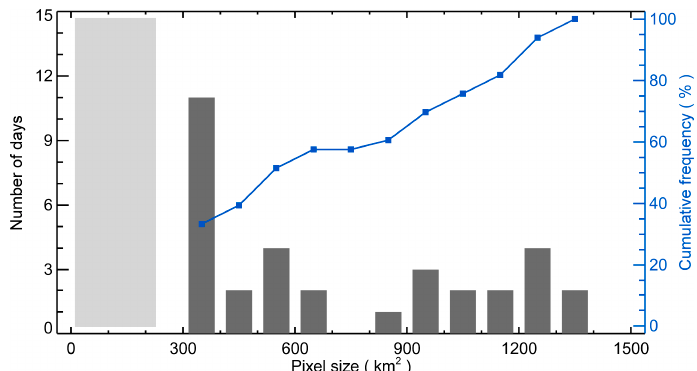
Figure 2. The size distribution of the Aura/OMI pixels passed over the South Korean region (126°E–130°E, 34°N–38°N). The solid line denotes cumulative frequency in percentage. A median size of the overpassing pixels on a day was selected as a representative pixel size of the day. Total 33 days are analyzed. The shaded area indicates a range of the cities’ sizes in South Korea.